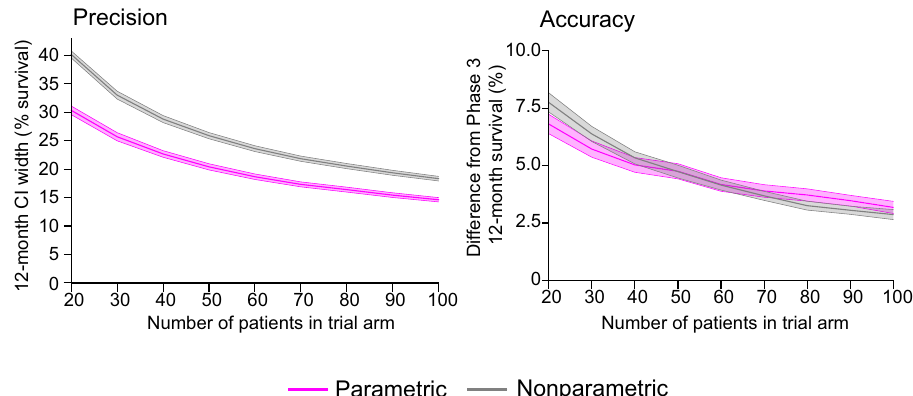
Fig. 4 Impact of parametric fi tting on the precision and accuracy of overall survival estimates. Comparison of nonparametric and parametric (Weibull distribution) methods to compute 12-month OS con fi dence intervals (CIs) for trials with small cohorts (20 – 100 patients) produced by randomly subsampling patient events from 125 actual trial arms. Note that nonparametric estimates did not return an informative con fi dence interval for 41% of OS curves (out of 213 OS curves with at least 100 patients), while Weibull fi tting made it possible to calculate 12-month con fi dence intervals for every survival curve in every simulation. Precision is de fi ned as the width of the con fi dence interval in percent survival. Accuracy is de fi ned as the absolute difference between the 12-month survival estimated from small cohorts and the value computed from all patients in a given Phase 3 trial arm. Lines denote mean values and shaded regions are 95% con fi dence